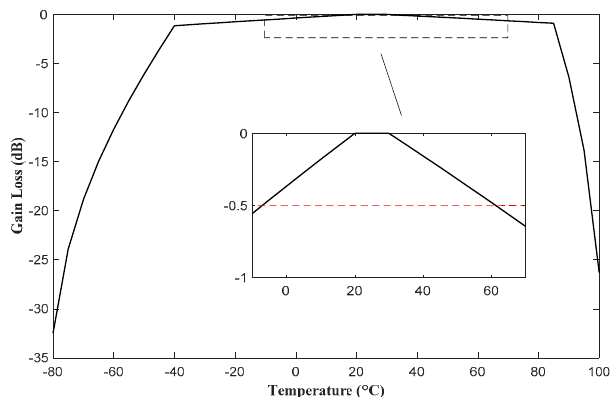
Figure 7. Gain-loss variation with temperature.